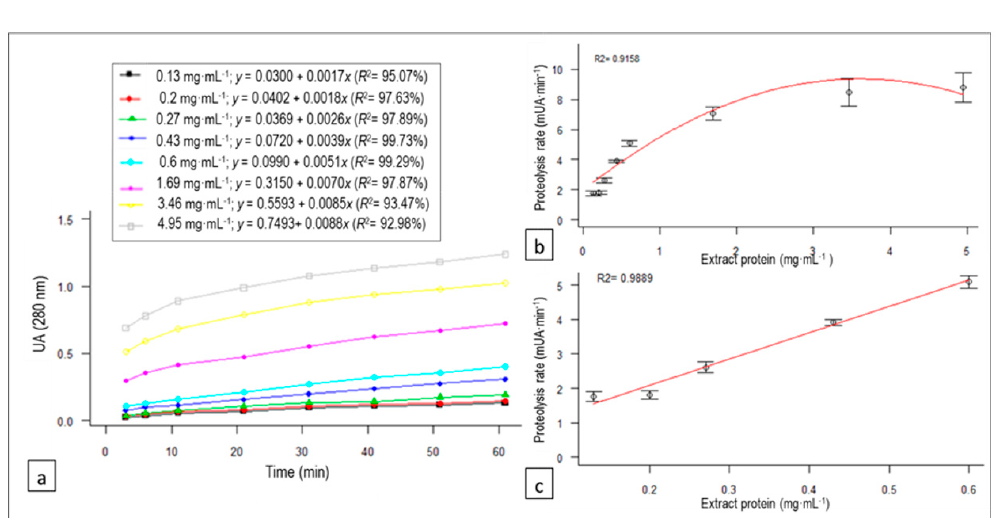
Figure 3. ( a ) Variation of absorbance (which correlates with proteolytic activity) with reaction time for each of the C. scolymus L. extract protein concentrations tested, as well as their regression equations and determination coe ffi cients ( R 2 ), for the proteolytic activity linear trend of the C. scolymus L. extract on bovine casein. ( b ) Quadratic regression model of the extract protein concentration e ff ect on the proteolysis rate of the C. scolymus L. extract on bovine casein. ( c ) Linear relationship between the C. scolymus L. extract protein concentration in the 0.13–0.6 mg · mL − 1 range selected and proteolysis